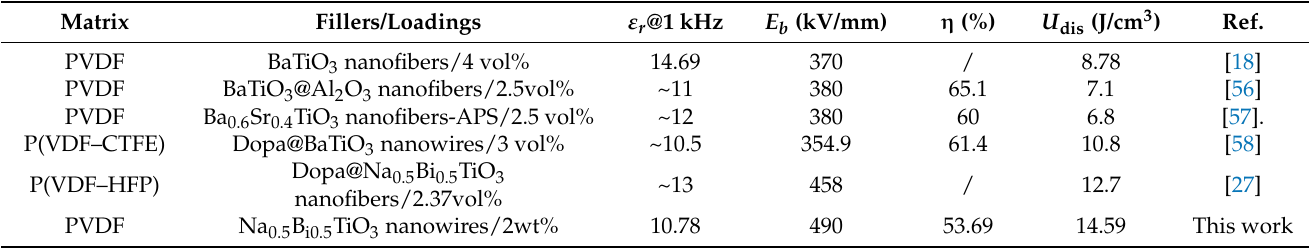
Table 2. Comparison of the dielectric constant ( ε r ), breakdown strength ( E b ), energy efficiency ( η ), and discharge energy density ( U dis ) for some typical dielectric